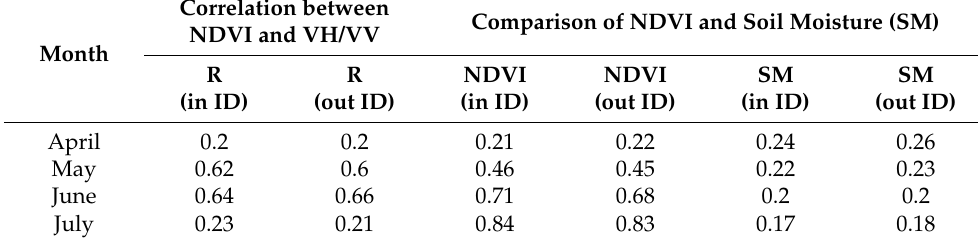
Table 1. Columns 2–3 Pearson correlation coefficients (R) between NDVI and VH/VV. For each month from April to July, the optical and radar responses were compared, considering all the maize fields and a 6–days frequency. R was calculated for the group of fields within and outside the irrigation districts (ID). Columns 4–7 comparison between mean monthly NDVI [–] and soil moisture [Vol water /Vol soil ] for the fields within and outside the irrigation districts (soil moisture refers to the soil upper layer: 3–5